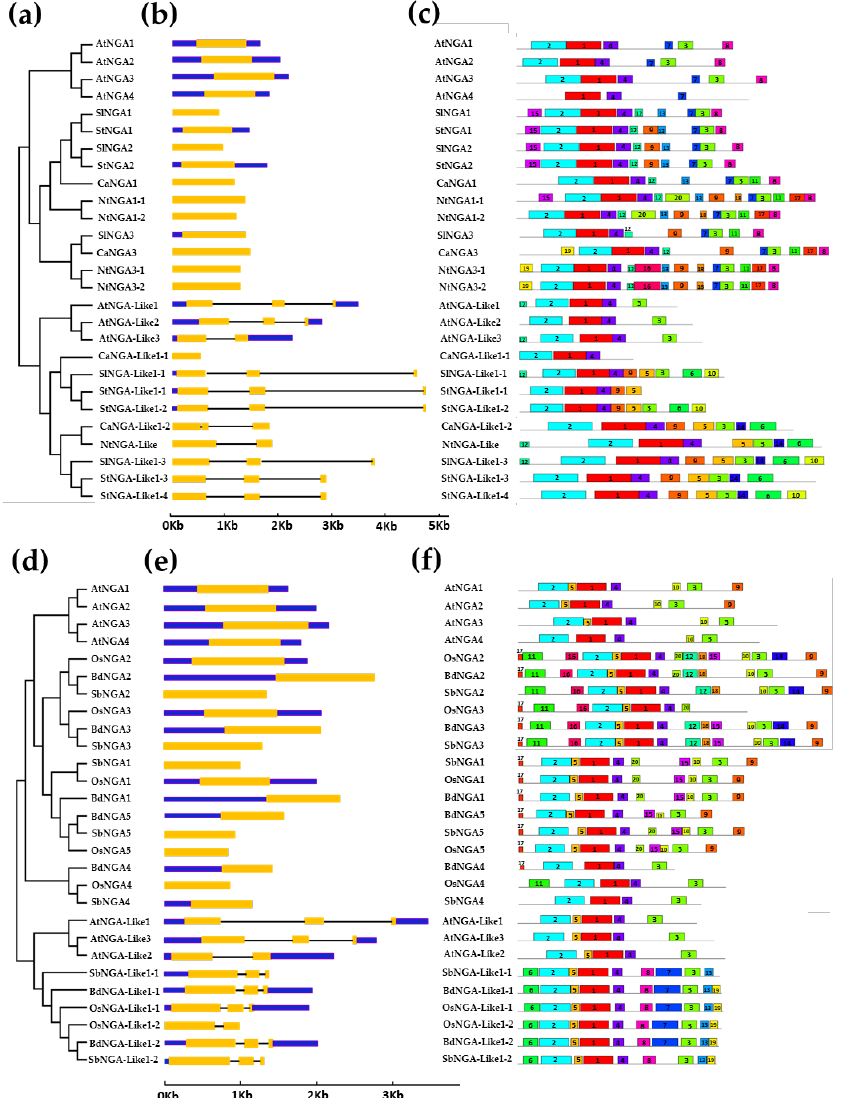
Figure 2. The structural analysis of NGATHA genes and their conserved protein motifs. ( a , d ) The phylogenetic tree and classification of NGATHA genes, ( b , e ) Exon – intron structures (where exons, introns and untranslated regions are represented by yellow bars, blue bars and black lines, respec- tively) and ( c , f ) protein motifs. ( a – c ) represent the gene structures and protein motifs of A. thaliana , S. lycopersicum , S. tuberosum , C. annuum , and N. tabacum , ( d – f ) represent the gene structures and protein motifs of A. thaliana , O. sativa , S. bicolor , and B. distachyon .